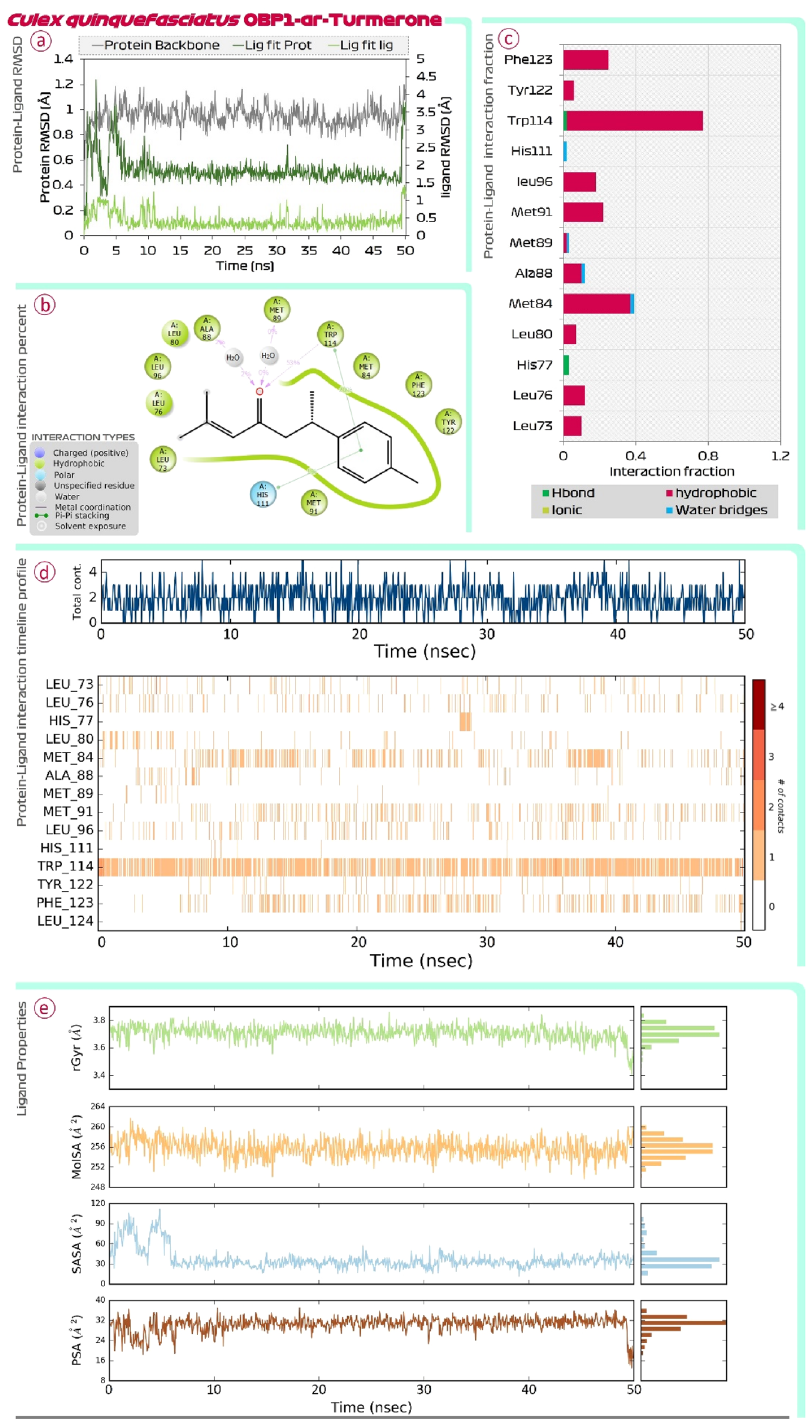
Figure 5. MD simulation assessment of ar-Turmerone-OBP1 (3OGN) complex of C. quinquefasciatus , ( a ) RMSD profile, ( b ) percent interaction, ( c ) interaction fraction profile, ( d ) interaction timeline profile and, ( e ) Ligand properties during simulation